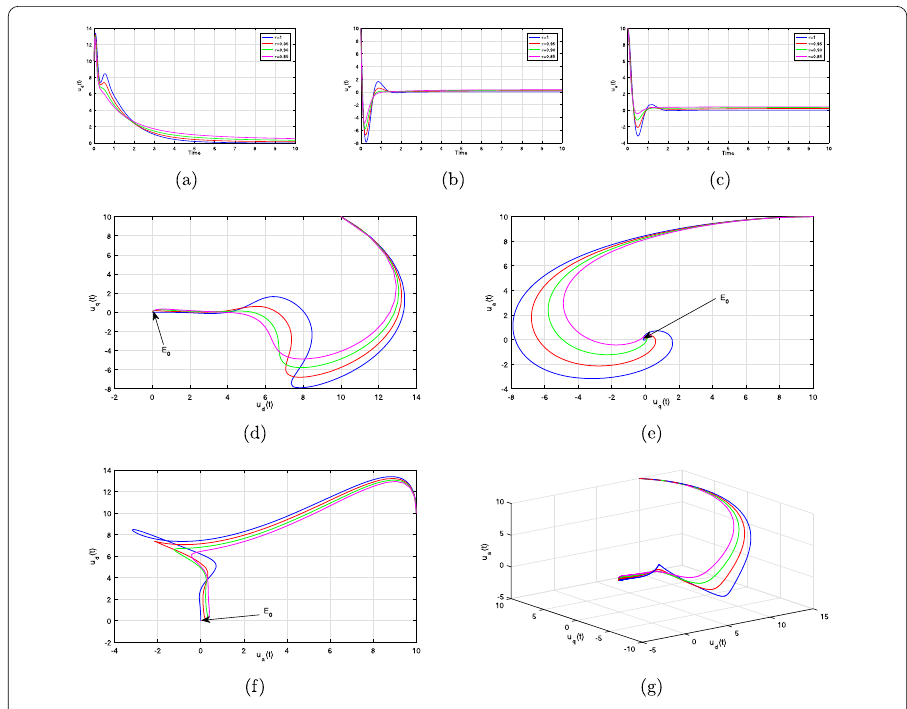
Figure 9 Simulations of Example 8 for time-fractional brushless DC motor (11) in the AB–Caputo sense